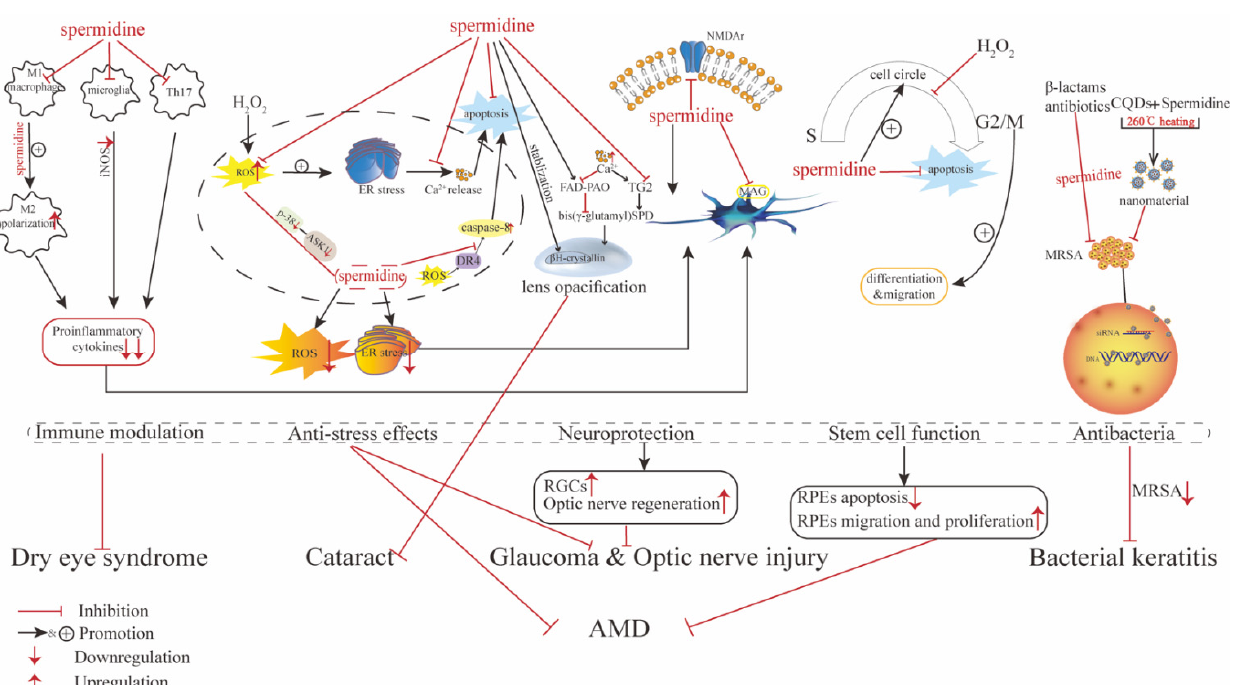
Table 1. A summary of altered levels of spermidine in ocular diseases.